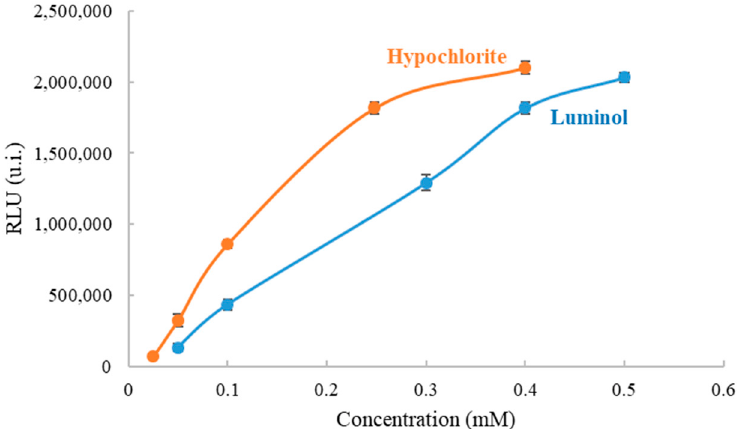
Figure 3. Optimization of concentration of hypochlorite and luminol working in solution to measure organic amino nitrogen and ammonium with a portable luminometer.